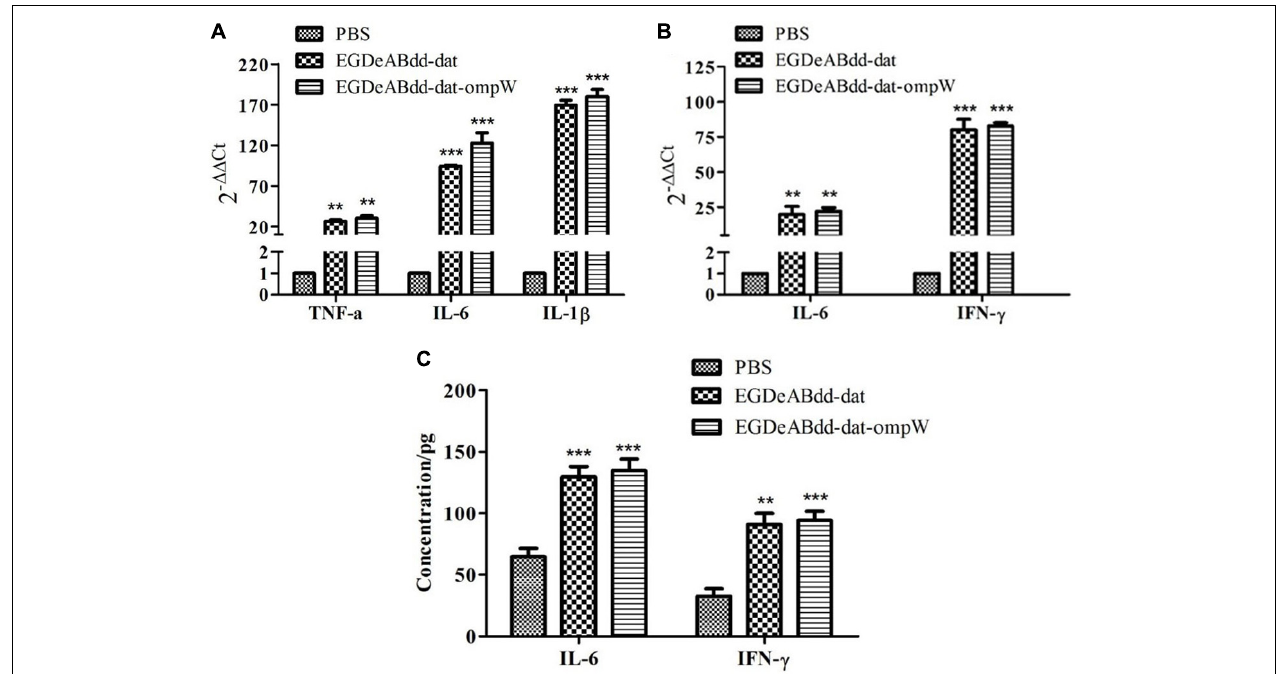
FIGURE 9 | Cytokine analysis of macrophages Raw264.7 and mouse splenocytes by RT-PCR and ELISA. (A) Cytokines of macrophages detected by RT-PCR. The multiplicity of infection (MOI) of bacteria and cells was 100:1, and incubation time was 3 h. (B) Cytokines of mouse splenocytes detected by RT-PCR. A dose of 5 × 10 7 colony-forming units (CFUs) of bacteria was injected into C57BL/6 mice, and phosphate-buffered saline (PBS) was the control. On the first day after immunization, the splenocytes were collected for RNA extraction. (C) Quantitative analysis of IL-6 from macrophages and IFN- γ from mouse splenocytes using sandwich ELISA. The mice were immunized by 5 × 10 7 CFUs of bacteria. On the third day after immunization, mouse serum was collected as antigen for sandwich ELISA. ** P < 0.01; *** P < 0.001.